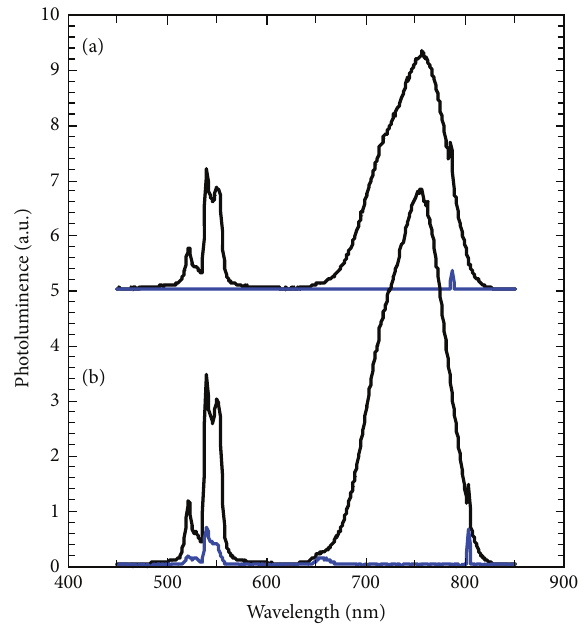
Figure 8: Demonstration of dye-induced upconversion of NaYF 4 nanoparticles doped with Er 3+ as both sensitizer and activator (NaY 0.85 Er 0.15 F 4 ). Plot (a) is for excitation at 785 nm where the attached DyL800 dye absorbs, but Er 3+ does not; the character- istic erbium upconversion spectrum is seen for the dye-attached nanoparticles (black curve) while no upconversion is seen for the control without attached dye (blue curve). Plot (b) is for excitation at801 nmwhereEr 3+ absorbs,butwhereabsorptionofthedyeisless.